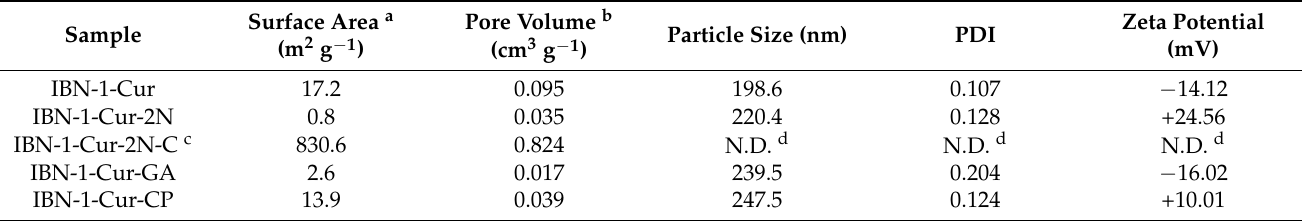
Table 1. IBN-1 and their modified samples display surface area, pore volume, particle size, polydis- persity index, and zeta potential.